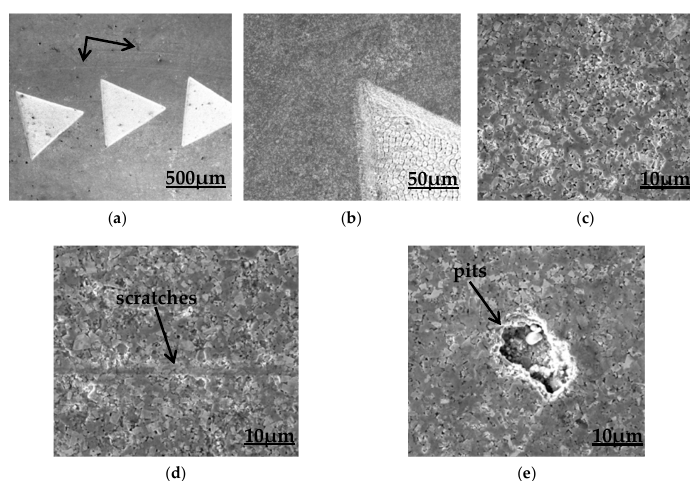
Figure 15. Surface wear morphology of triangular textured specimens. ( a ) Triangular textured surface wear morphology with a scale of 500 μ m; ( b ) Triangular textured surface wear morphology with a scale of 50 μ m; ( c ) Triangular textured surface wear morphology with a scale of 10 μ m; ( d ) Triangular textured surface wear morphology with a scale of 10 μ m; ( e ) Triangular textured surface wear morphology with a scale of 10 μ m.